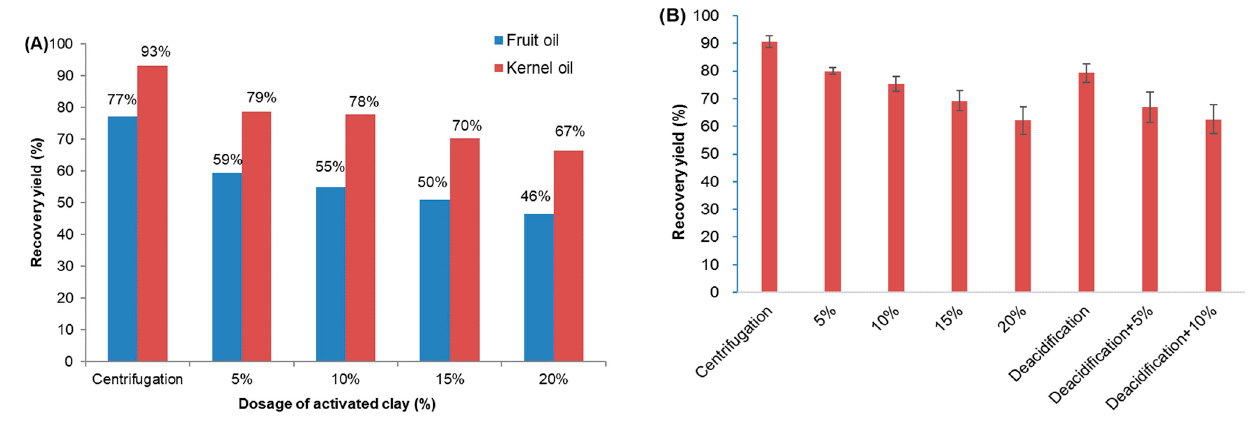
Figure 5. The recovery yield of Litsea cubeba fruit and kernel oils after decoloration using ( A ) activated clay only and ( B ) alkali deacidification combined with using activated clay. Table 3. The effect of different refining methods on the basic physicochemical properties of Litsea cubeba kernel and fruit oils.